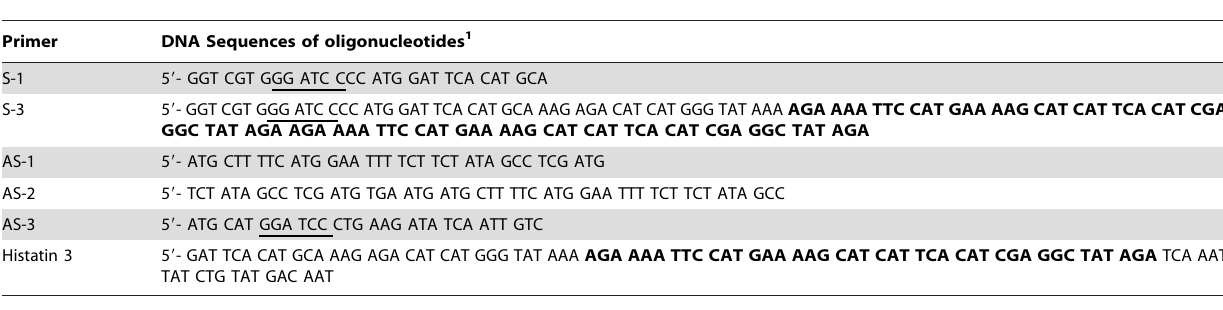
1 Bolded nucleotide regions represent the functional domain; underlined nucleotide regions represent the BamHI cleavage site. doi:10.1371/journal.pone.0051479.t001 PLOS ONE |